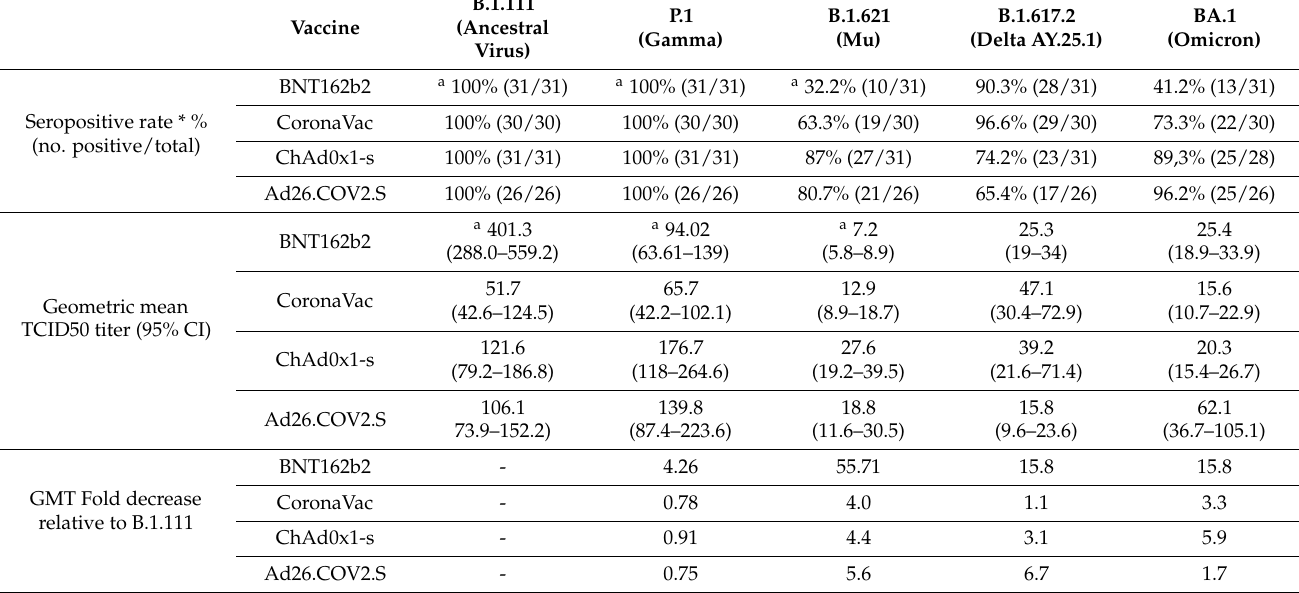
Table 2. Summary of vaccine antibody responses against SARS-CoV-2